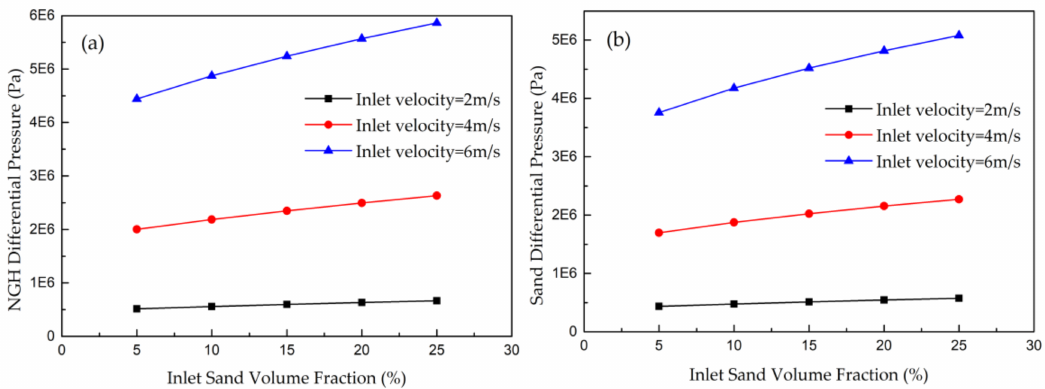
Figure 18. The relationship between inlet sand volume fraction and e ffi ciency: ( a ) is for NGH, ( b ) is for